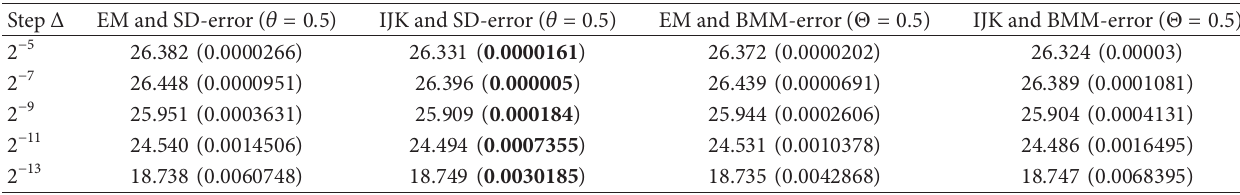
Table 7: 98% error, step size, and average computational time of numerical integration of process (𝑆 𝑡 ) using log-Euler or IJK method with SD or BMM scheme for (1) with (𝑥 0 ,𝑆 0 ,𝜇,𝑘 1 , 𝑘 2 ,𝑘 3 , 𝑞, 𝑇) = (1/16, 100, 0.05, 1/16, 1,0.4,3/4, 1) , correlation 𝜌 = −0.4 . Step Δ EM and SD-error (𝜃 = 0.5) IJK and SD-error (𝜃 = 0.5)